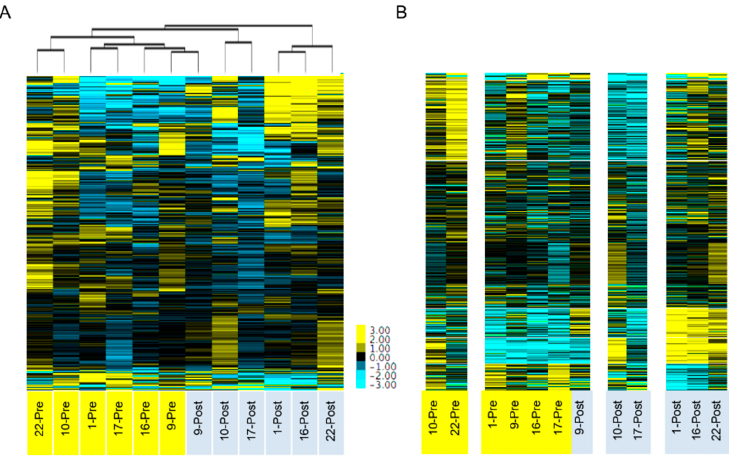
Figure 2. Unsupervised hierarchical clustering and K-means clustering. Clustering of samples using the top 366 highly variable genes (average deviation > 50). ( A ) Unsupervised hierarchical clustering with dendrogram. ( B ) K-means clustering (k = 4). Samples are labeled by patient ID numbers and Pre or Post, depicting pre-NACT and post-NACT samples. Int. J. Mol. Sci. 2019 , 20 , x FOR PEER REVIEW